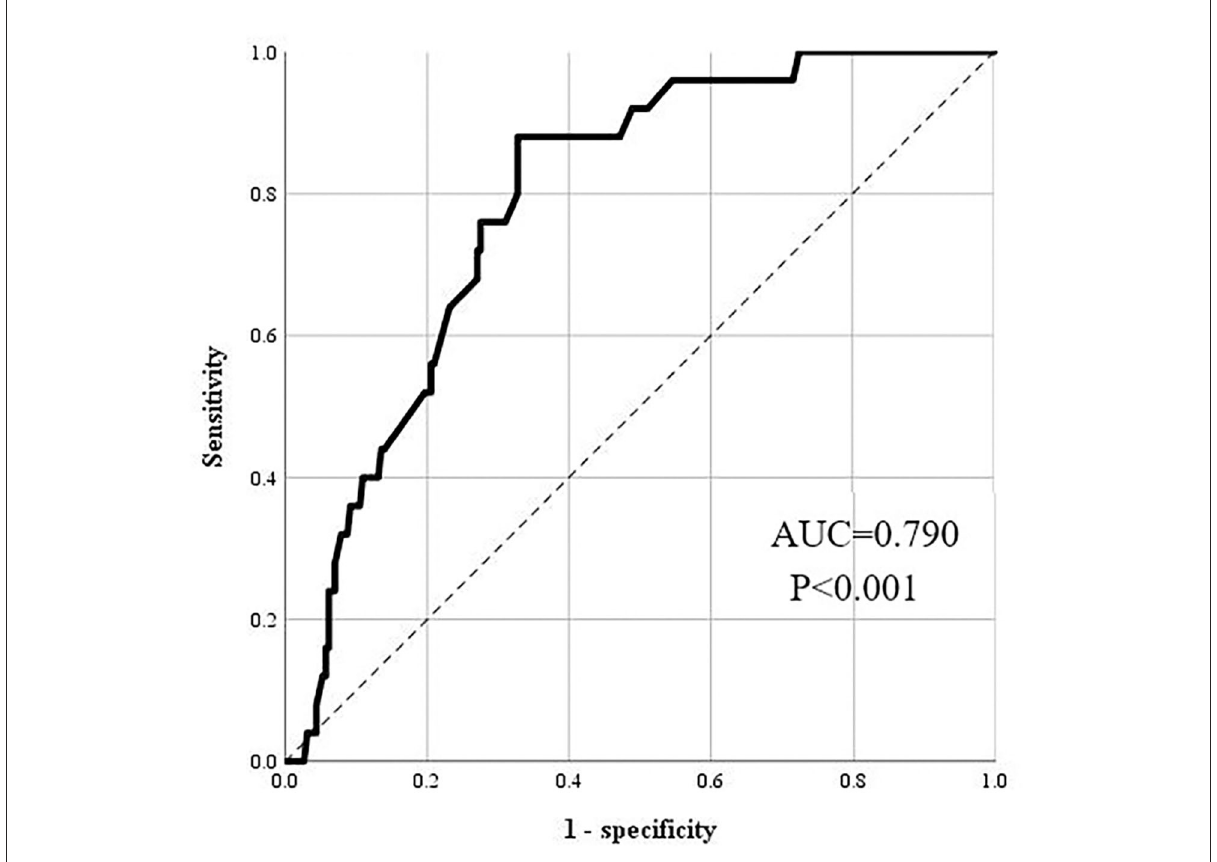
FIGURE2 The ROC analysis of the regression